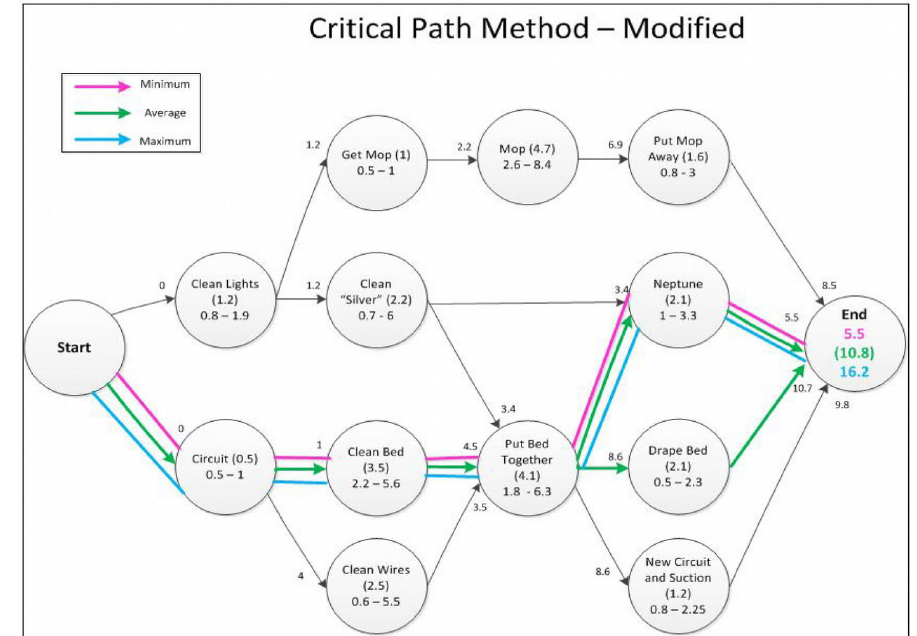
Figure 5. CPM modified with trash and linens assumption